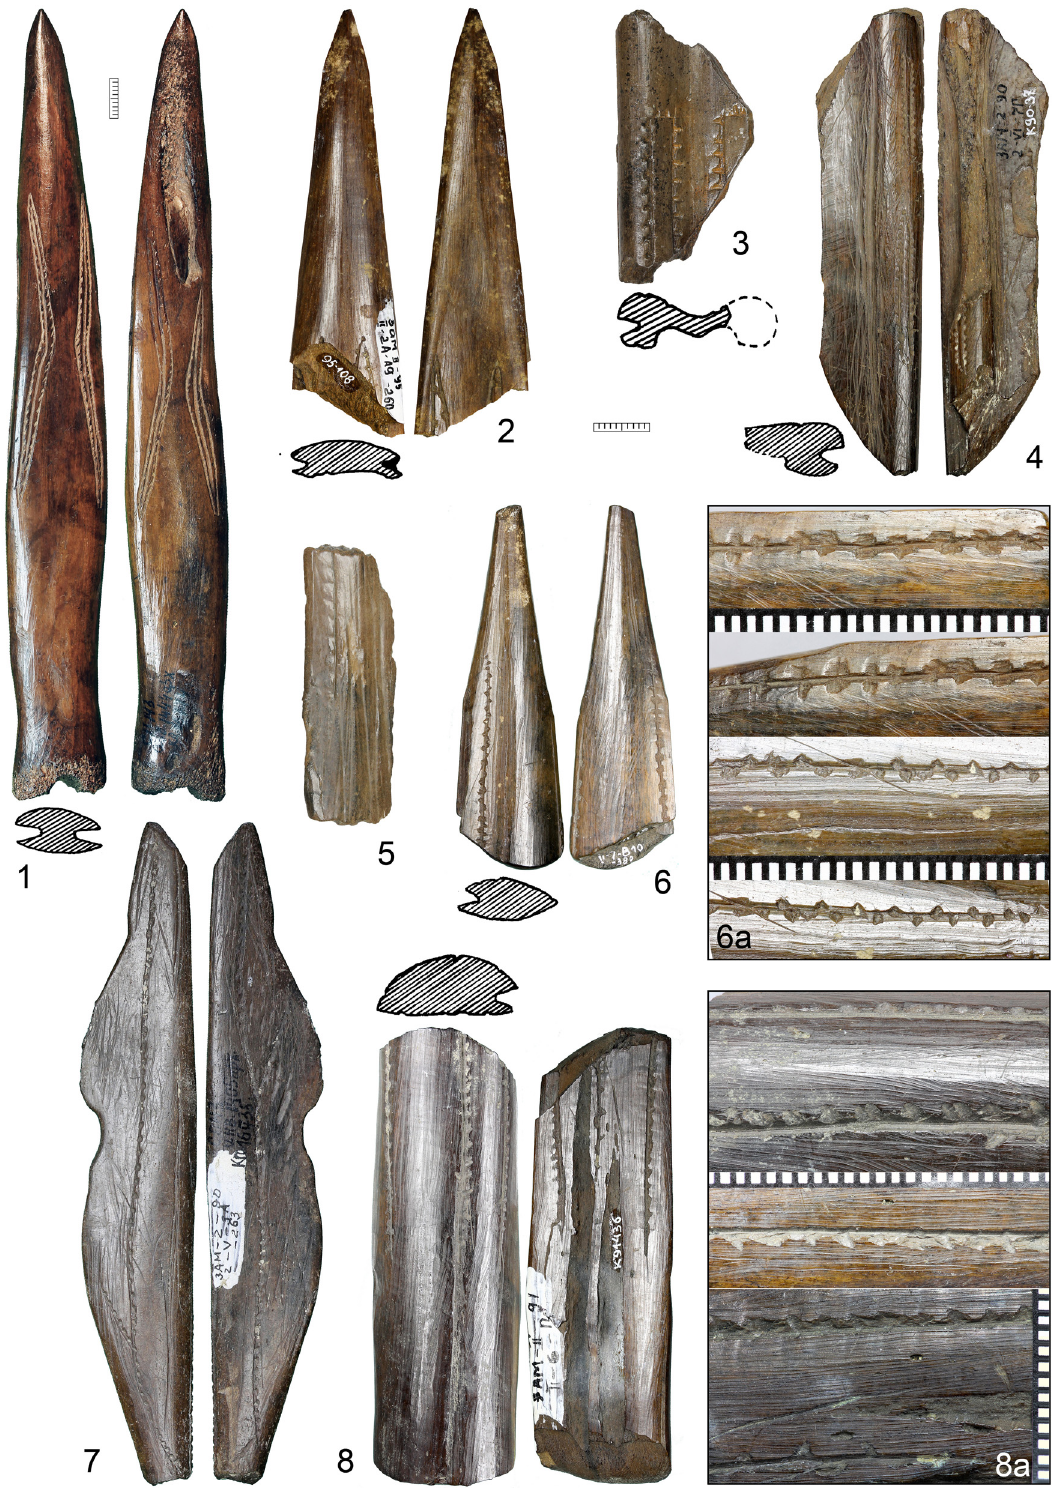
Figure 9: Zamostje 2. ( 1 – 2 ) slotted daggers; ( 3 – 6, 8 ) fragments of slotted tools; ( 7 ) knife. Late Mesolithic ( 4, and 6 – 8 ) ; Early Neolithic ( 5 ) ; unde fi ned ( 1 – 3 )